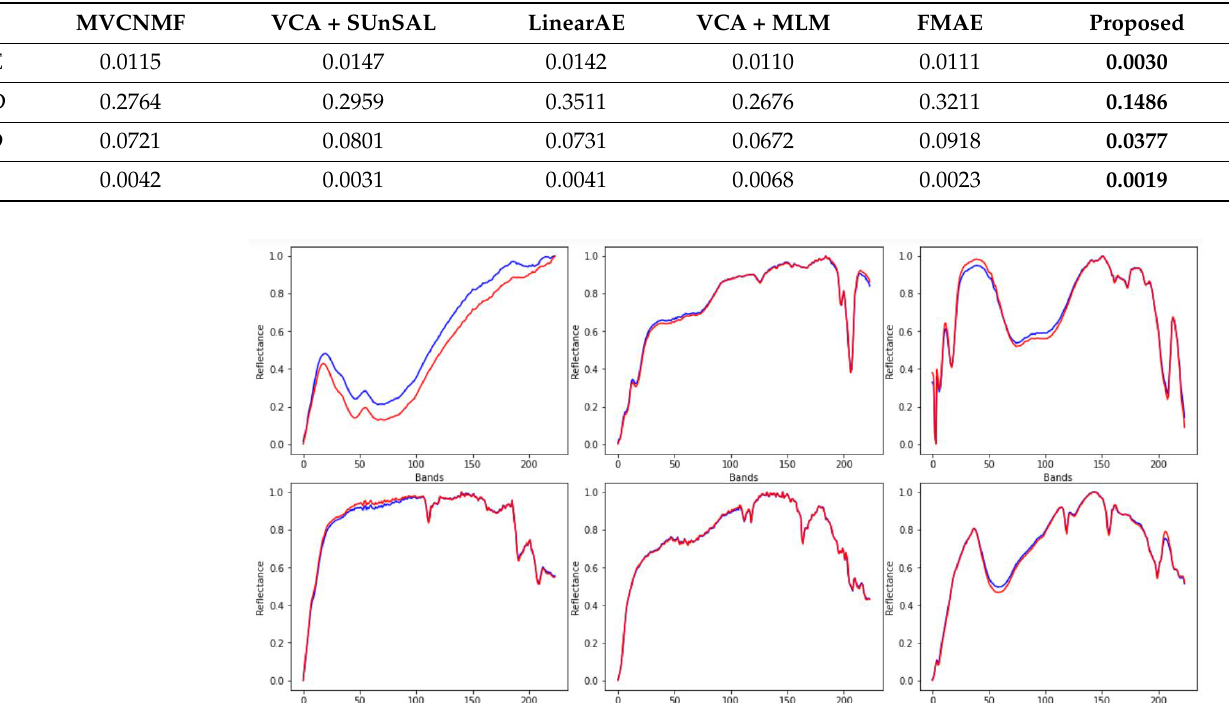
Figure 3. Six selected endmember spectral signatures in USGS. Table 2. Comparison of different methods on Nonlinear Mixed Data. Best results are reported in bold.